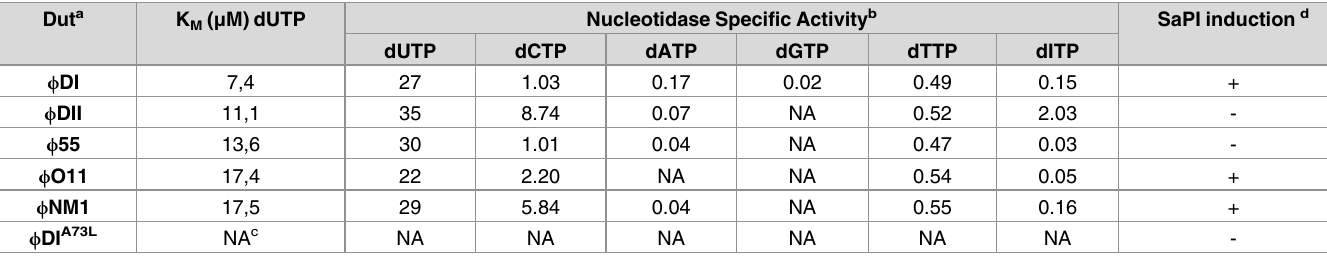
Table 2. Nucleotidase activity. Dut